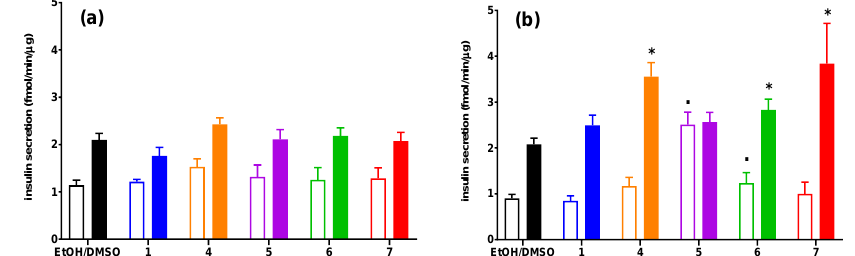
Figure 3. Glucose-stimulated insulin secretion (GSIS) in MIN6 cells stimulated with p -anisic acid (1), phosphatidylcholines substituted with at anisic and / or palmitoyl acyl residues in di ff erent configurations (4–6), and 1-anisoyl-LPC (7) at either 25 µ M ( a ) or 50 µ M ( b ) concentration versus compound solvent control (EtOH / DMSO). Results are presented for insulin secreted at 2 mM glucose conditions (open bars) and 20 mM glucose conditions (closed bars). p < 0.05 for secretion significantly di ff erent from 2 mM glucose control (.) and 20 mM glucose control (*).